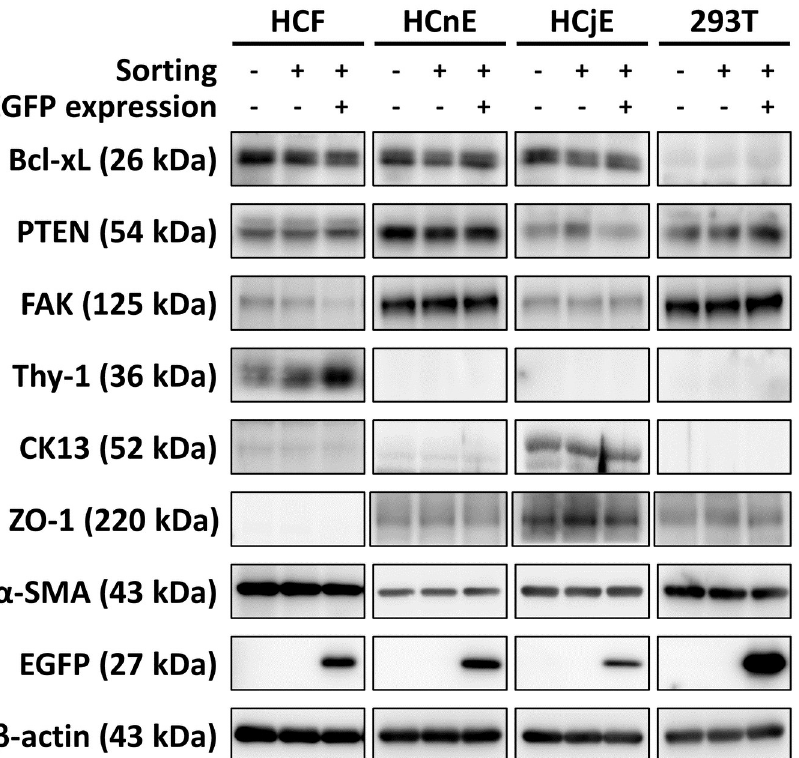
Fig 5. Alteration of cell type-specific expression proteins in the sorted EGFP-expressing cells. Non-transduced cells, sorted EGFP-negative cells, and sorted EGFP-positive cells of the four cell types were separately cultured in 6-cm dishes, and the cell lysates were prepared for immunoblotting analysis of cell type-specific protein profiles. This experiment was performed three times with similar results. Bcl-xL, B-cell lymphoma-extra large; PTEN, phosphatase and tensin homolog; FAK, focal adhesion kinase; CK13, cytokeratin-13; ZO-1, zonula occludens-1; α -SMA, alpha- smooth muscle actin; EGFP, enhanced green fluorescent protein.